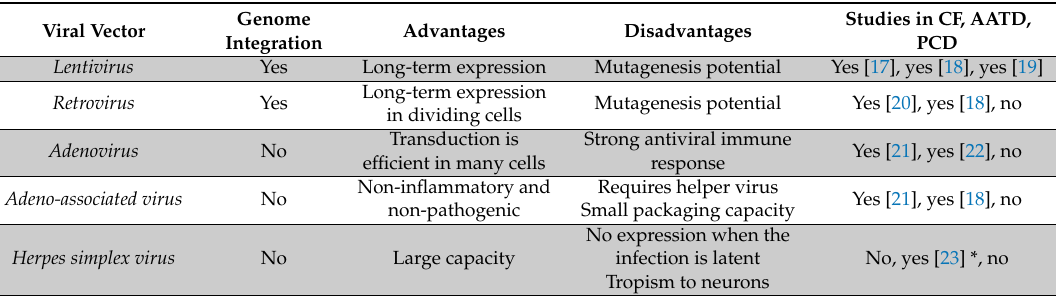
Table 1. Viral vectors used in gene therapy reporting genome integration capability and summary of main advantages and drawbacks. The “studies in CF, AATD, PCD” column shows if there are any in vitro or in vivo studies using the viral method. * Herpes simplex virus is used as a complementation method for the adeno-associated virus. CF (Cystic fibrosis), AATD (Alpha 1 antitrypsin deficiency), PCD (Primary ciliary dyskinesia).